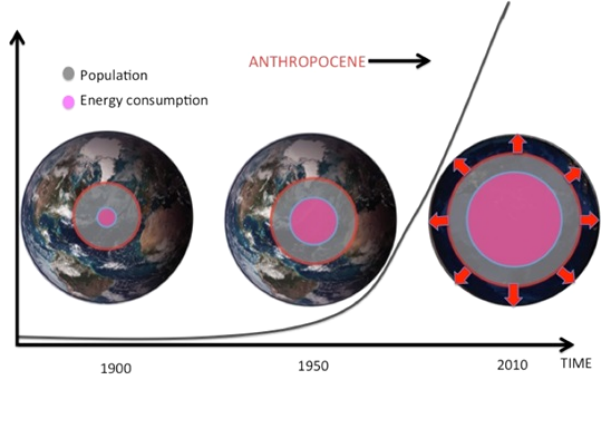
Fig. 1 . An appropriate conceptualization for sustainable development places the economy and society within Earth’s life-support system. The figure illustrates how the balance between these components has changed rapidly over the past century, leading to the need to reappraise the relationship among components today. Energy is used as a surrogate for consumption and economic growth; population growth is used to illustrate changes in the relative size of the social domain compared to the Earth system’s ability to deliver services, which has not changed